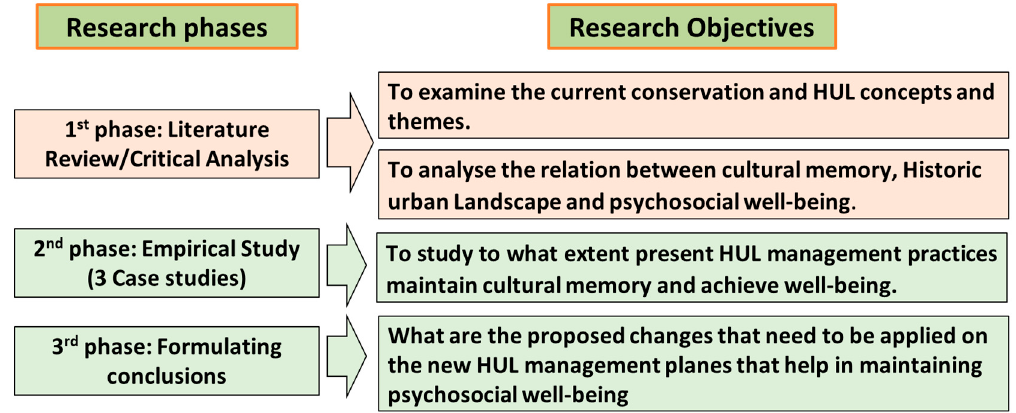
Figure 2. The three research phases and the intended research objective of each phase. Source: F. Hussein.